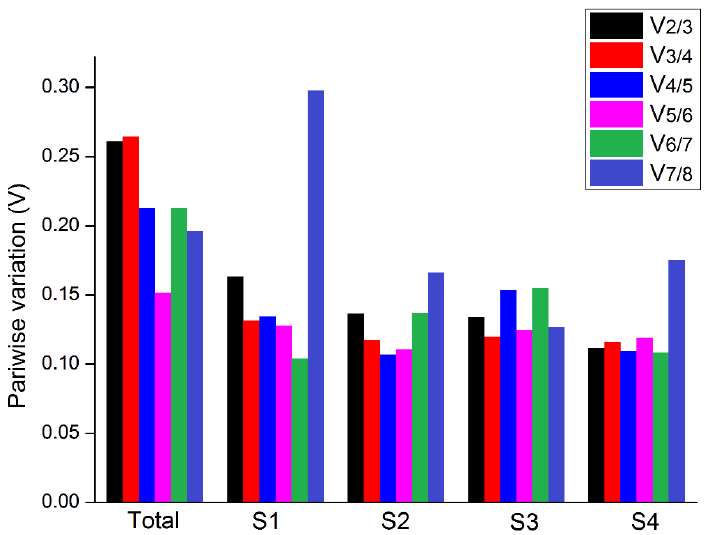
Figure 6. Pairwise comparative analysis of eight reference genes in B. juncea.